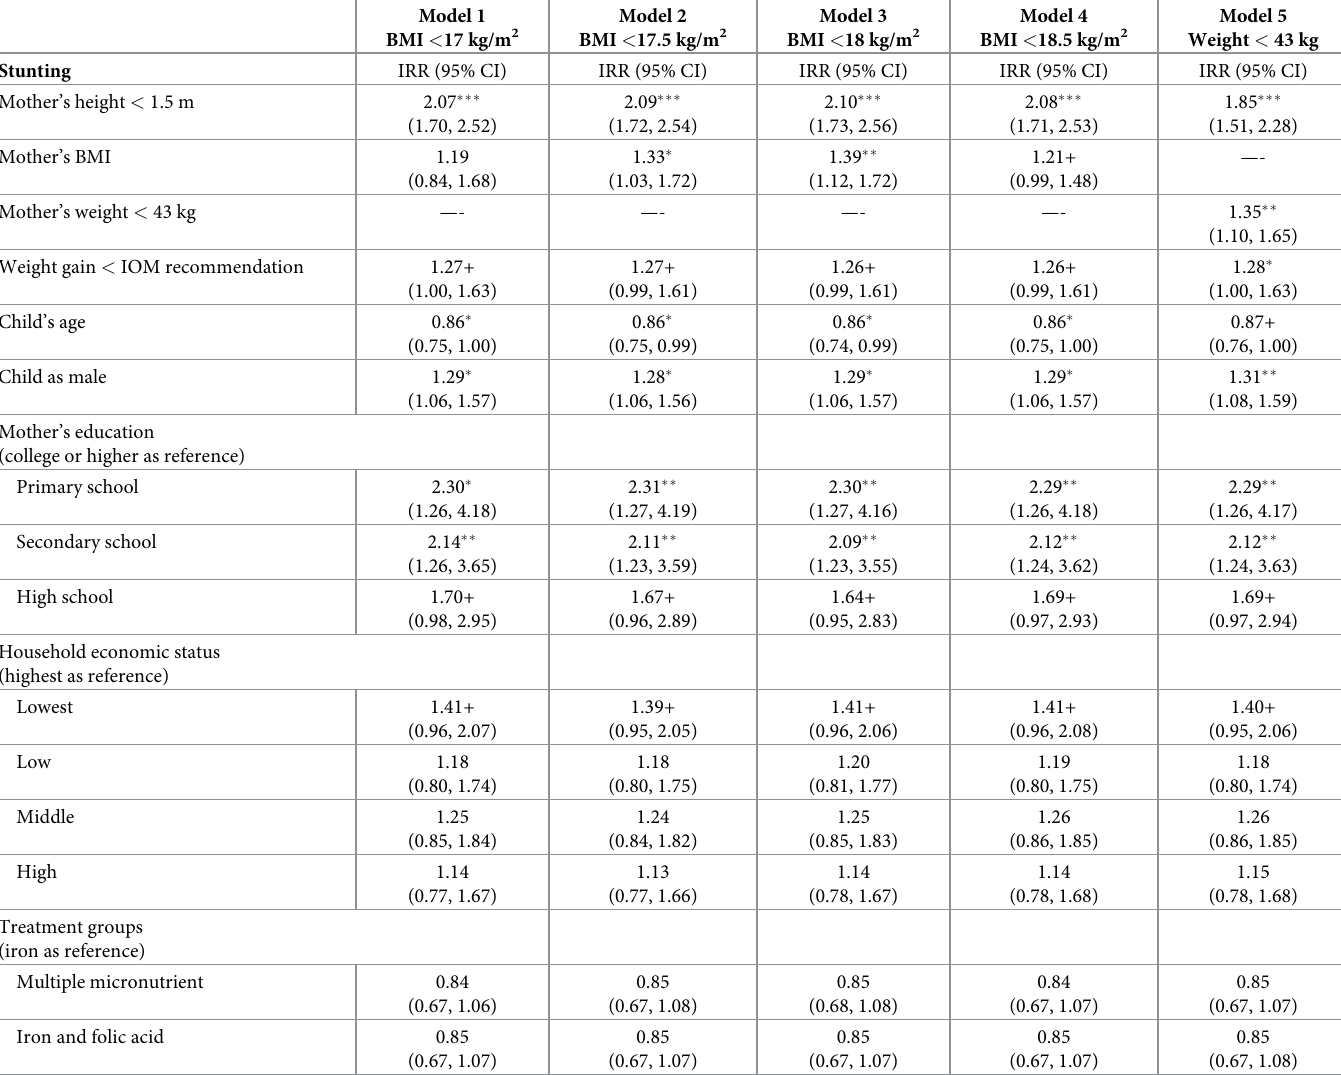
Table 2. Risk of child stunting at 2 years of age by maternal preconception nutritional